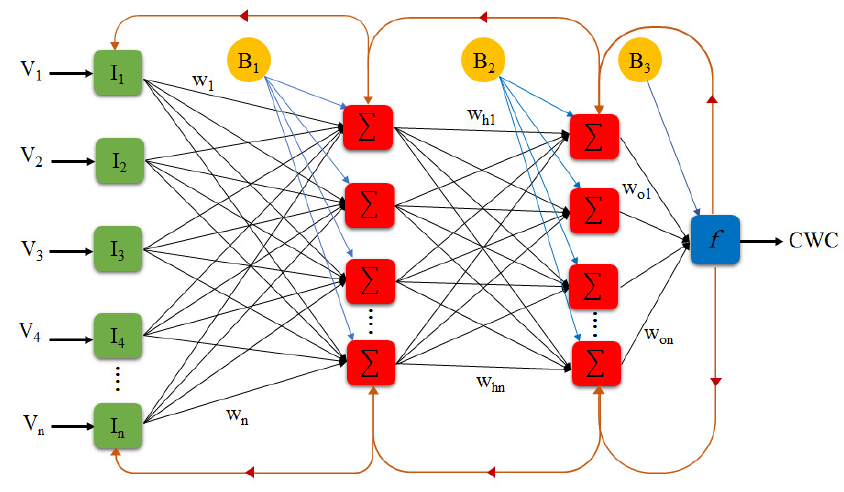
Figure 4. The architecture of an artificial neural network.